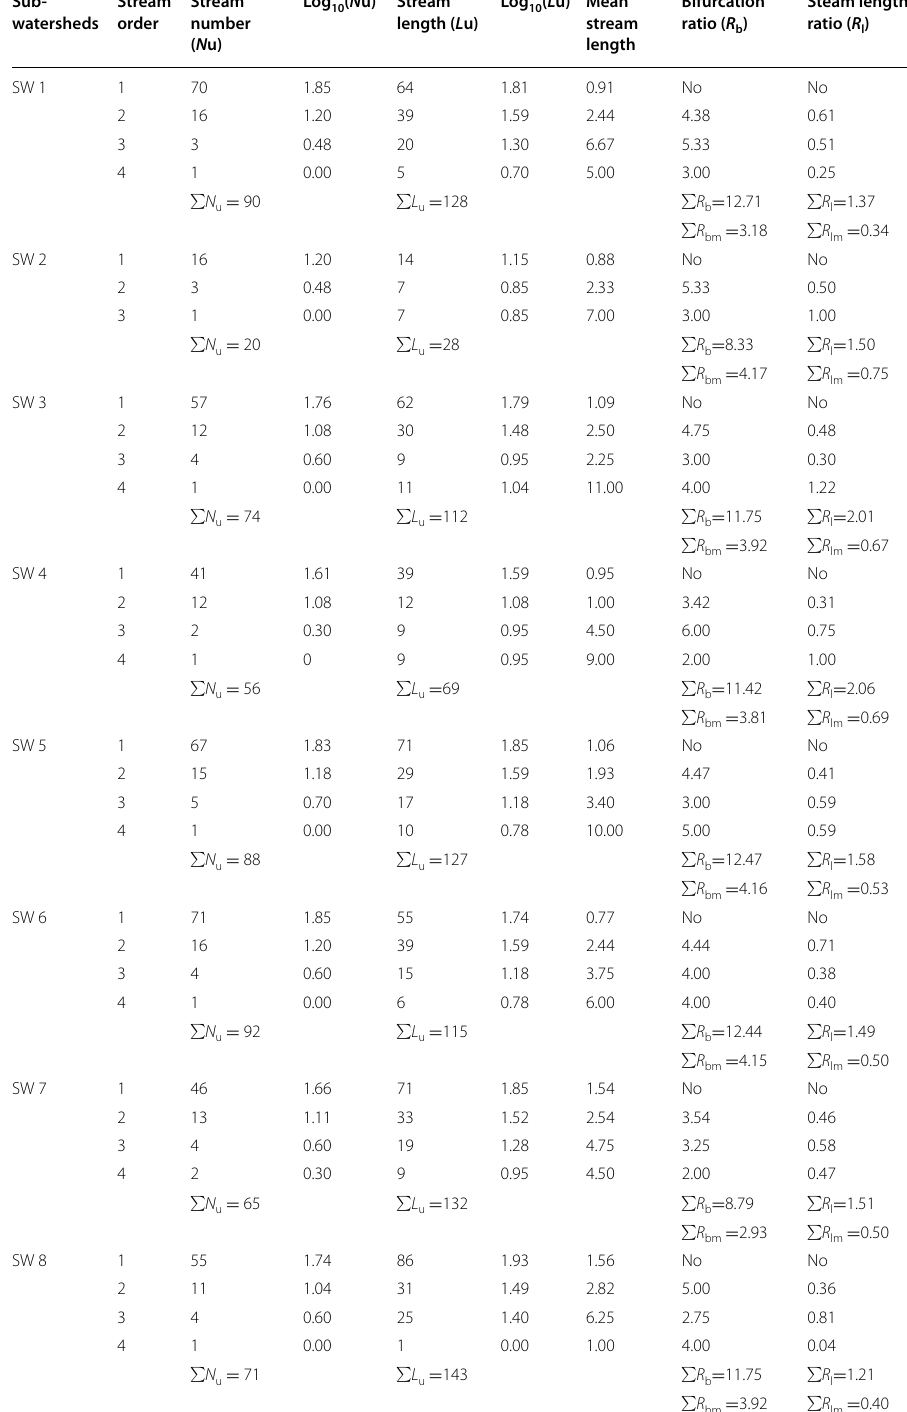
Table 3 Linear parameters of the Murredu River basin (SW 1 to SW 14) Sub- Stream watersheds